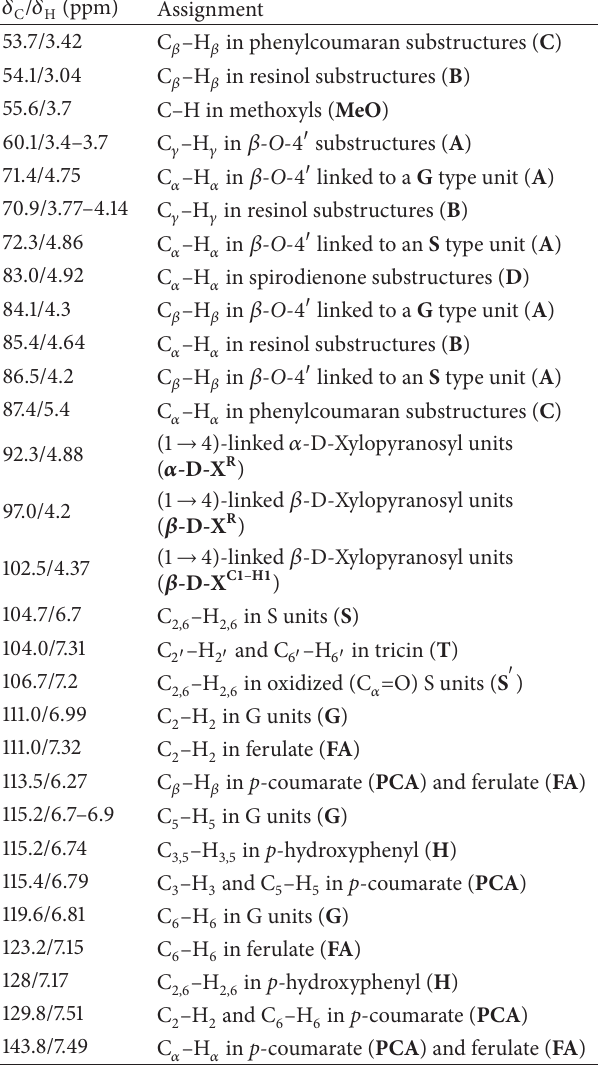
Table 2: Assignment of main lignin and sugars 13 C– 1 H cross signals in the HSQC spectra of lignin-rich residues from wheat straw and olive tree pruning WIS